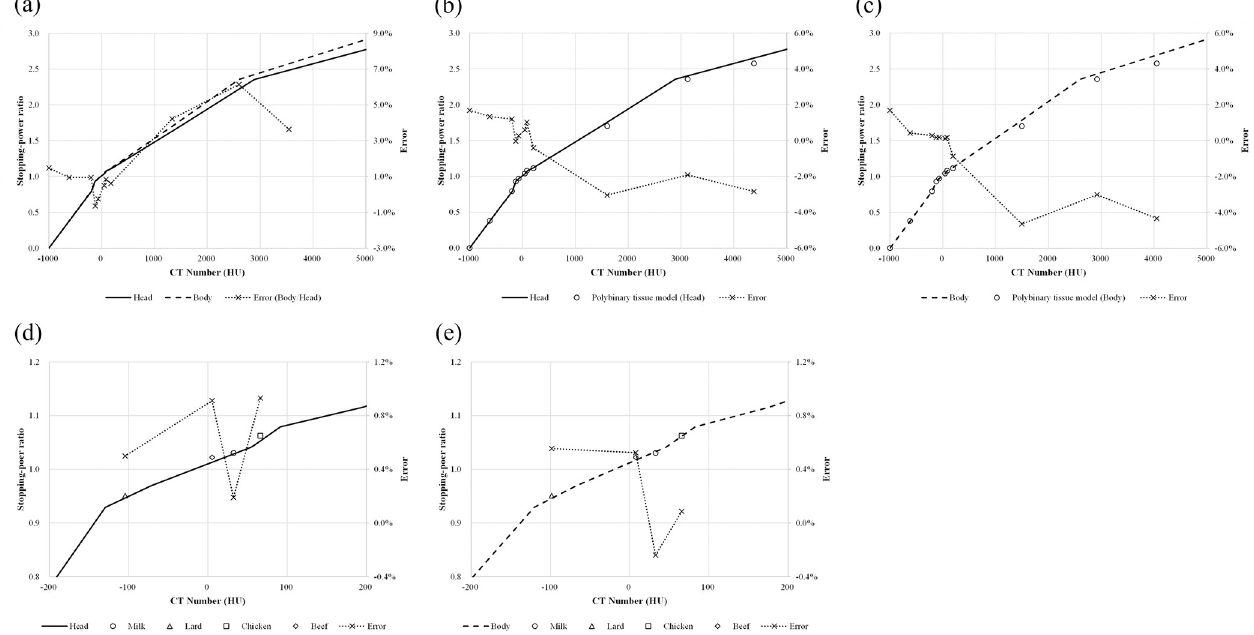
Fig 1. CT number-to-RSP curve created with stoichiometric calibration. (a) Relationship between head and body cancer cases—solid lines: head case; dashed lines: body case; dotted lines with crosses: errors. Comparison of curves obtained using our method and using a polybinary tissue model for (b) head and (c) body; the circles show the polybinary tissue model. Comparison between the calculated stopping-power ratio and those measured for materials representing (d) head and (e) body—circles: milk; triangles: lard; squares: chicken; diamonds: beef.